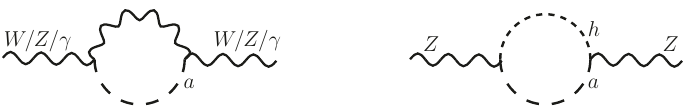
Figure 25 . One-loop Feynman diagrams contributing to electroweak precision